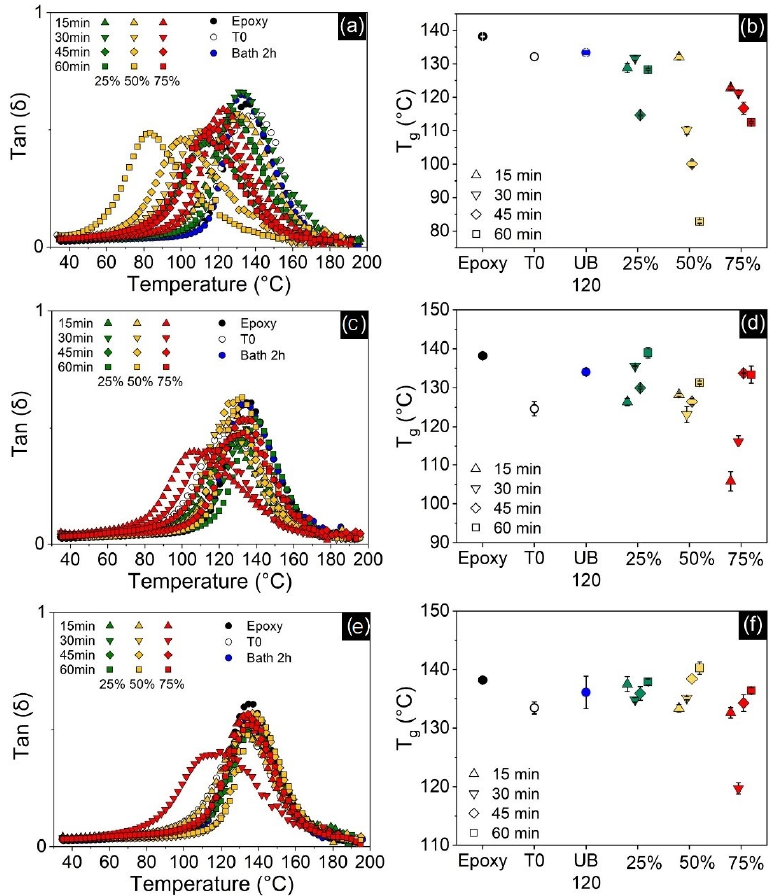
Figure 11. Tan ( δ ) curves (left) and T g results (right) for all nanocomposites compared to neat epoxy and as functions of processing methods. CNT-filled at the top ( a , b ); GNP-filled in the middle ( c , d ); and hybrid-filled nanocomposites at the bottom ( e , f ). T0 denotes the unprocessed samples and UB 120 the samples processed in the ultrasonic